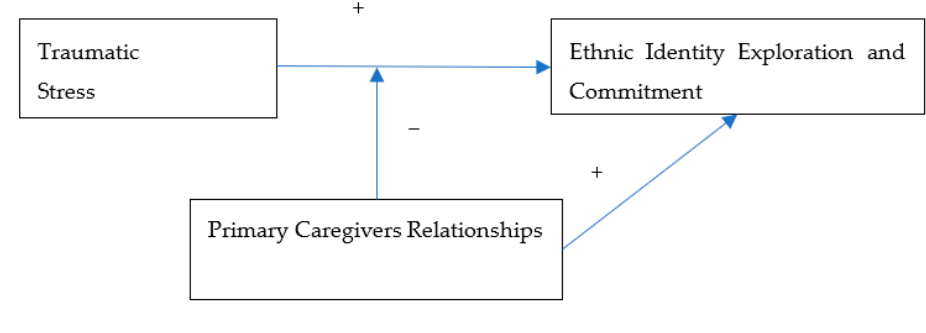
Figure 1. Conceptual model.